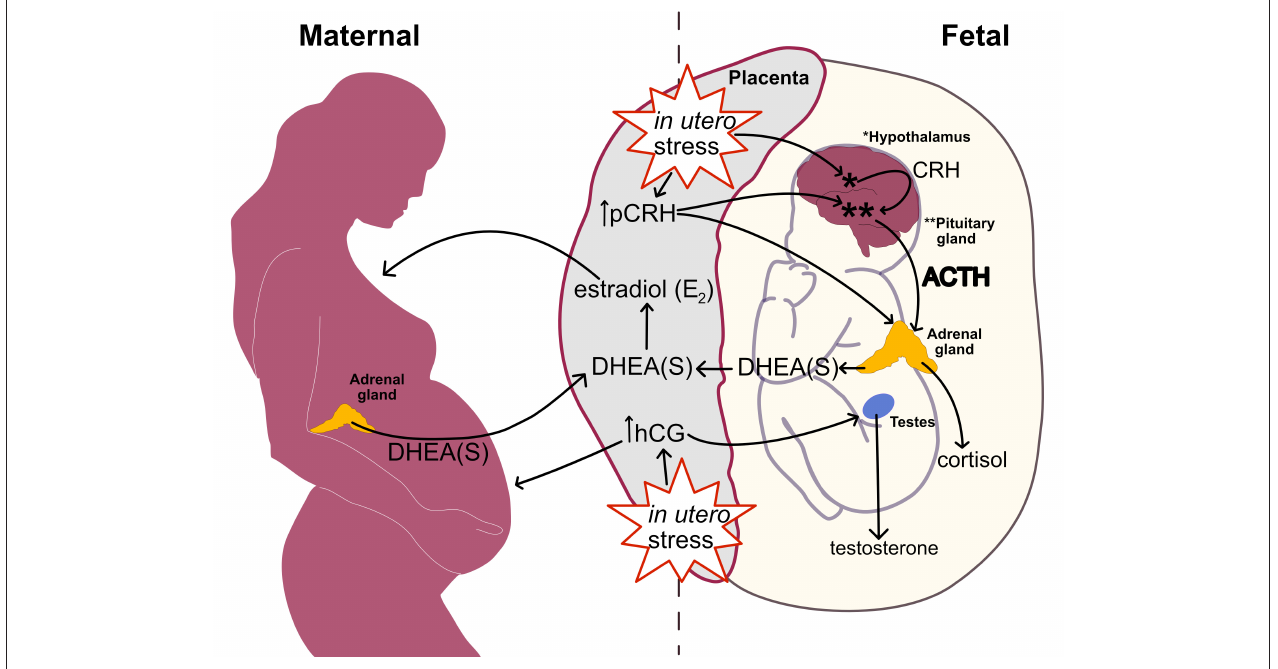
FIGURE 3 | Linking in utero stress to increased fetal steroidogenic activity and ASD biomarkers at